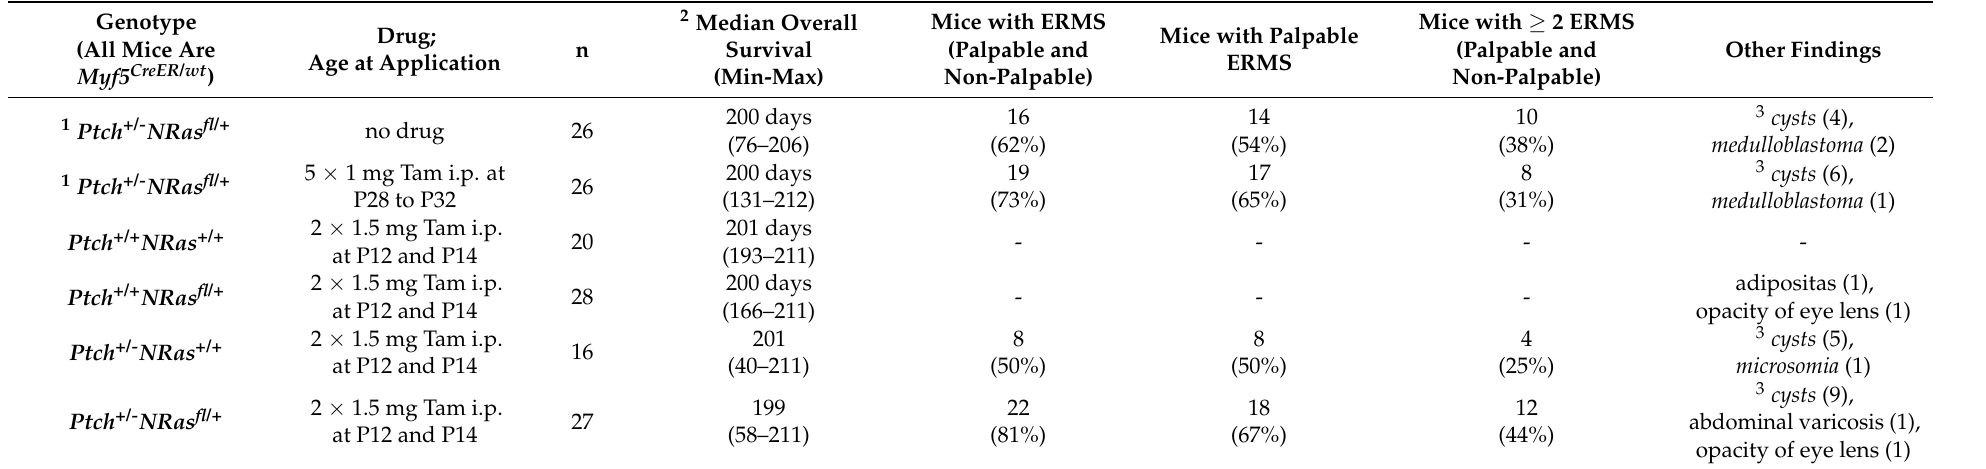
Table 1. Mice used for the